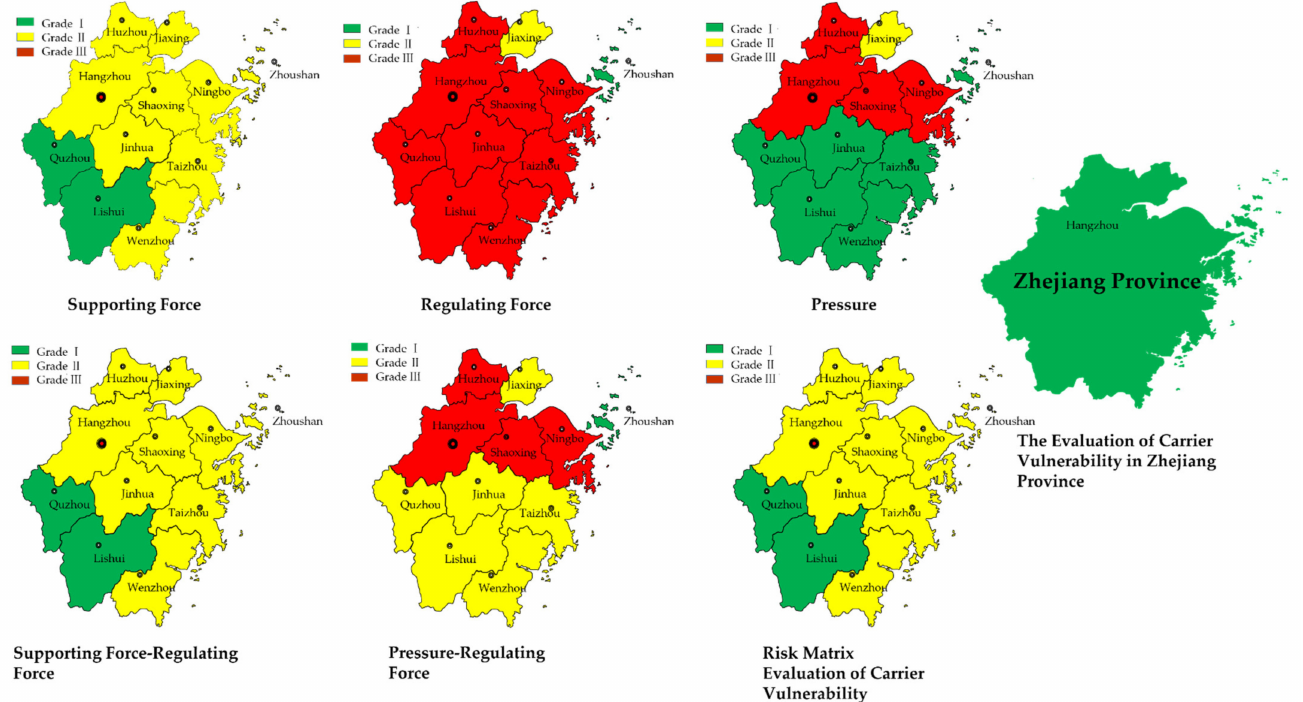
Figure 2. Evaluation grade of the risk matrix for the vulnerability of disaster-bearers in Zhejiang